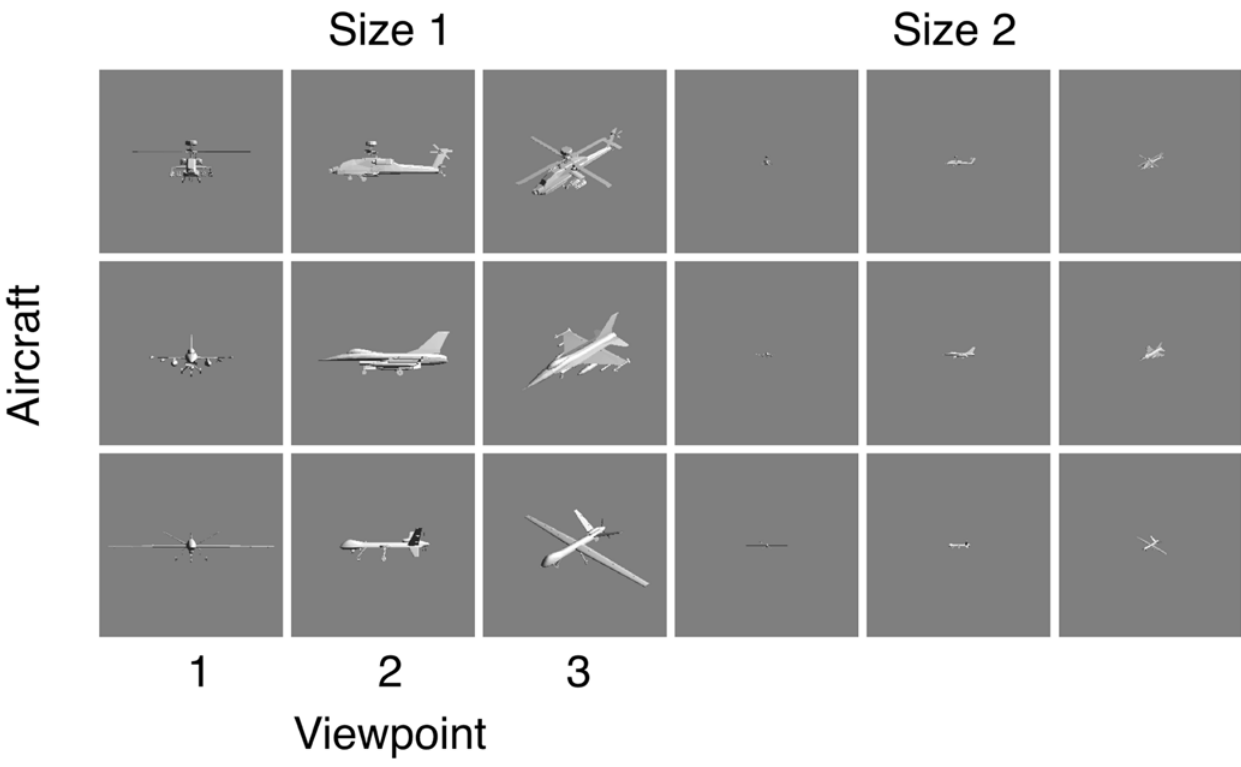
Figure 11. Images of aircraft varying in orientation, size, and type. These images were used to test the effect of viewpoint on the contrast